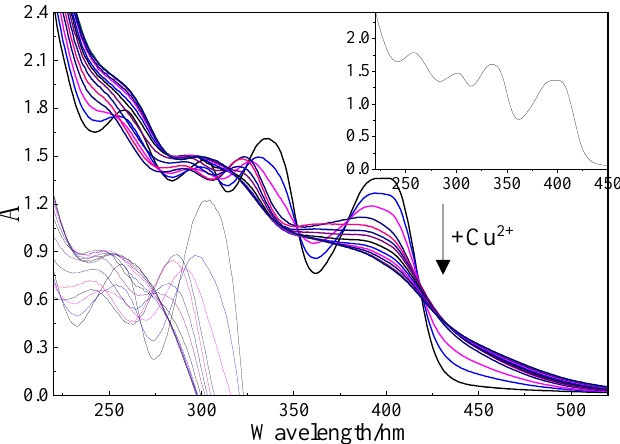
Figure 7. UV–Vis spectroscopy of methanobactin (Mb) following the addition of Cu(II) (0–480 × 10 −9 mol). The inset panel to the top right shows pure Mb, and the inset picture to the left is a magnified view of the variation of characteristic peaks at 301 nm and 336 nm.